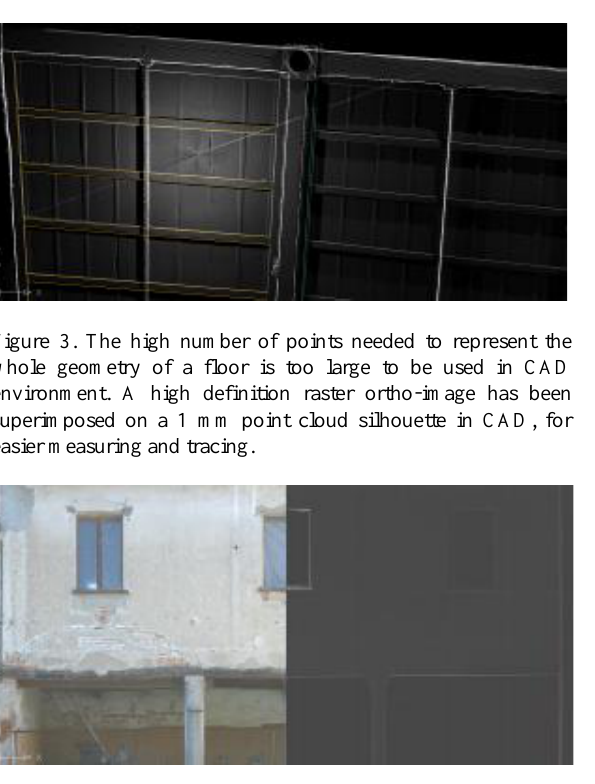
Figure 4. Point cloud as a reference for the perspective rectification needed for further architectural